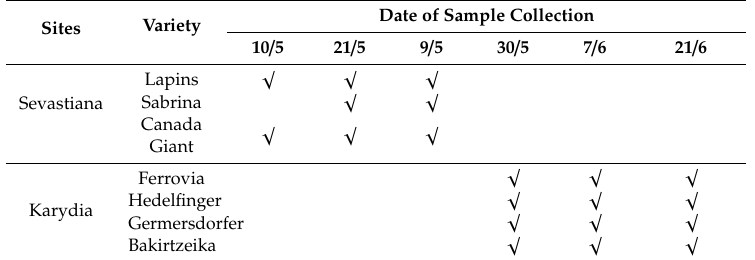
Table 3. The sites, the cherry varieties and the dates of fruit sample collection for